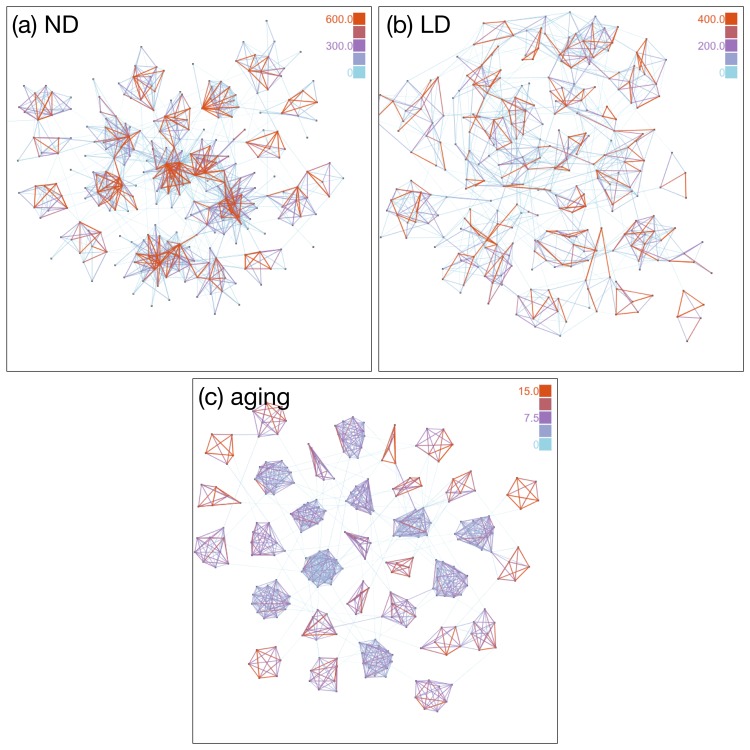
Network snapshots.Snapshots of typical network structures for (a) ND, (b) LD, and (c) aging mechanisms of link removals. Networks are drawn by using a force-directed graph drawing algorithm. Parameters are controlled such that these three networks have comparable average degrees (see Table 1). Color of links denotes the link weight. Strong and weak links are depicted in red and light blue, respectively. Note that different color scales are used for visibility. For the aging mechanism, community structures are clearly visible and the link weights in each community are more homogeneous. In the networks using the ND and LD mechanisms, strong and weak links coexist in each community.